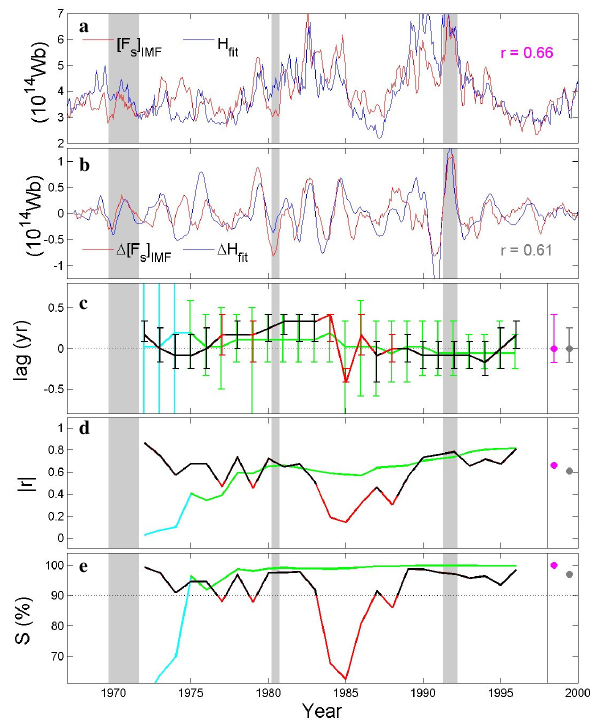
Fig. 10. The same as Fig. 9, for the correlation analysis of Climax neutron monitor ( > 3GV) counts C and the open solar flux deduced from the radial component of the IMF [ Fs ] IMF .